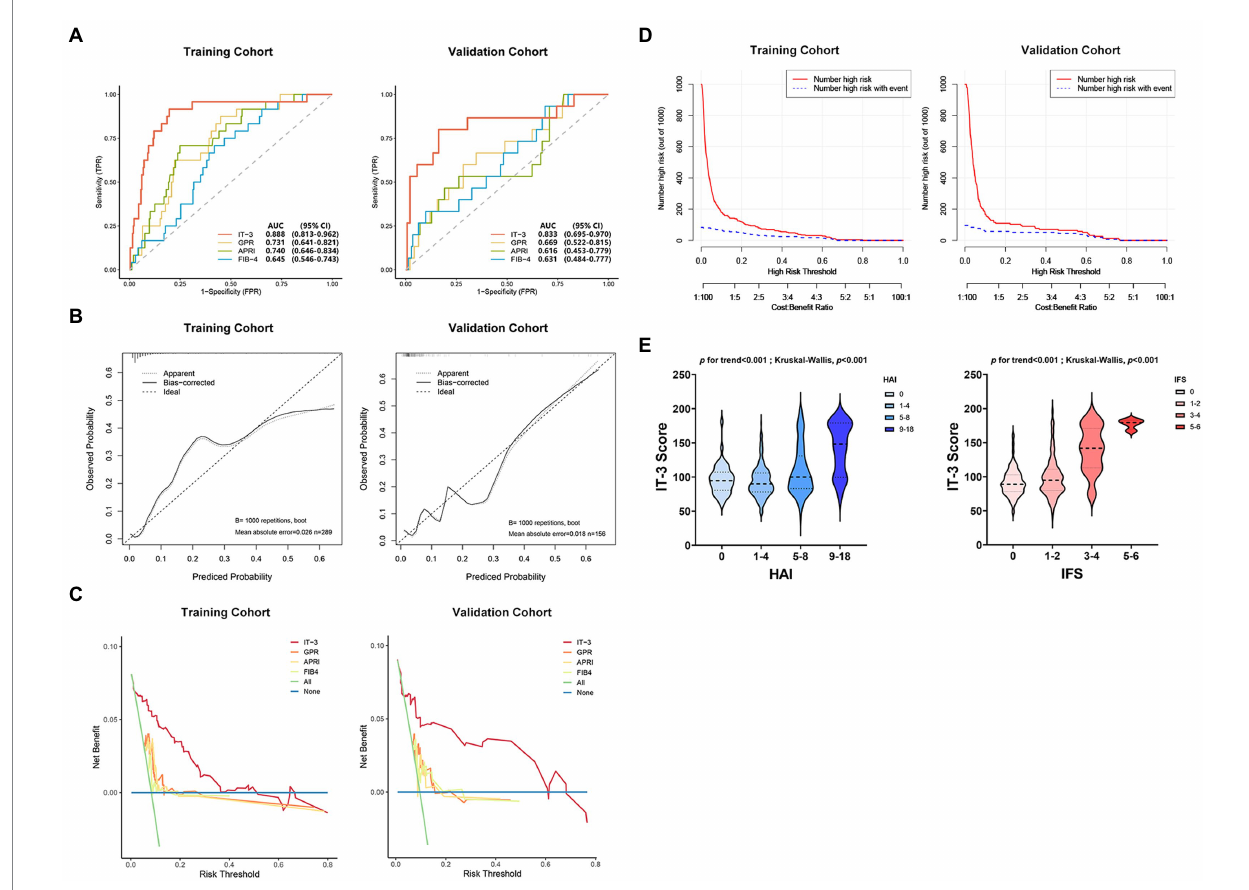
FIGURE 3 The IT-3 model performance evaluation. (A) Comparison of the area under the curve (AUC) between the IT-3 model and other nonivasive models. (B) Calibration curves. (C) Comparison of the decision curve analysis between the IT-3 model and other nonivasive models. (D) Clinical impact curves. (E) Relationship between IT-3 scores and liver pathology. APRI, aspartate aminotransferaseto-platelet ratio index; AUC, the area under the curve; FIB-4, fibrosis index based on the four factors; GPR, gamma-glutamyl transpeptidase to platelet ratio; HAI, histology activity index; IFS, Ishak fibrosis score.